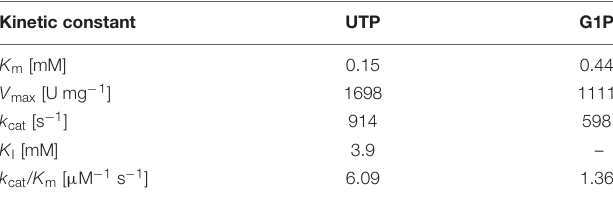
TABLE 3 | Kinetic constants for free Ta GalU calculated by the fits. Kinetic